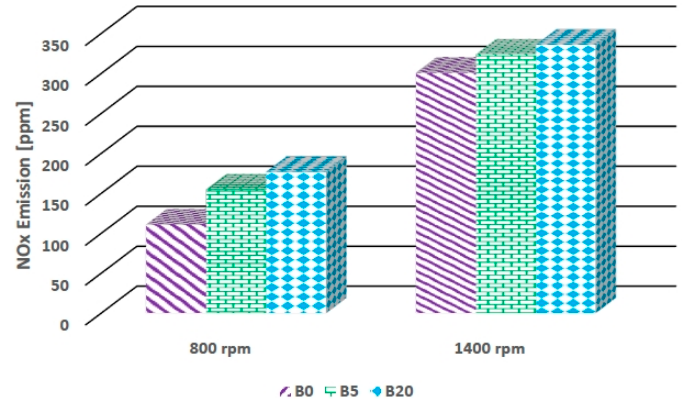
Figure 10. Variation of nitrogen oxides emission with speeds.